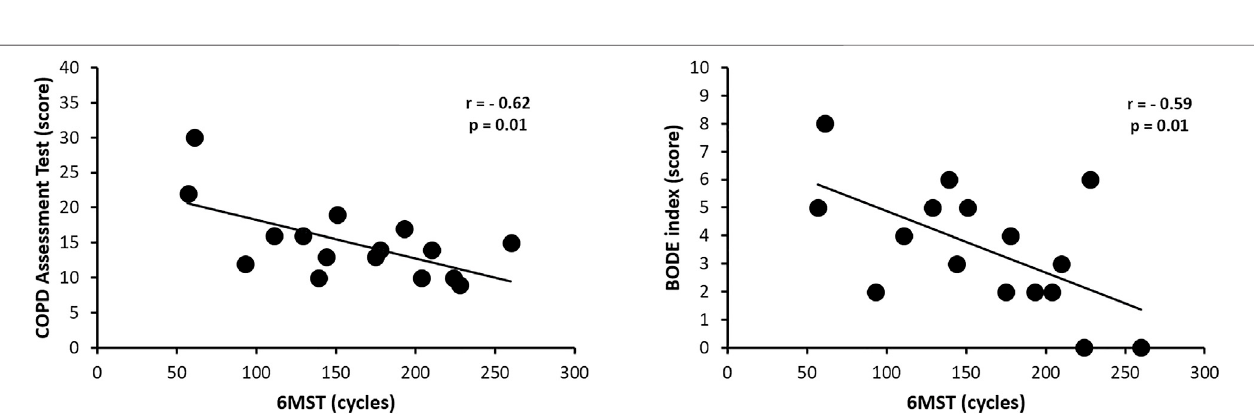
FIGURE 5 | Correlation of 6MST performance with the COPD Assessment Test and the BODE index. Abbreviations: 6MST, 6-min stepper test.